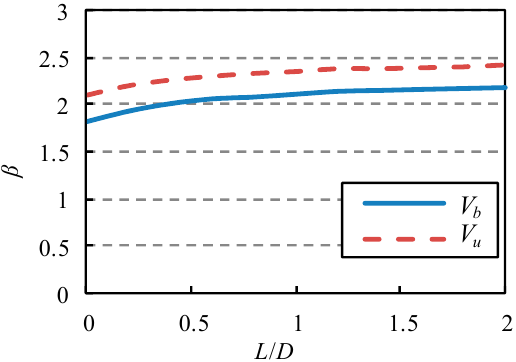
Figure 8. Reliability indexes β of V b and V u .